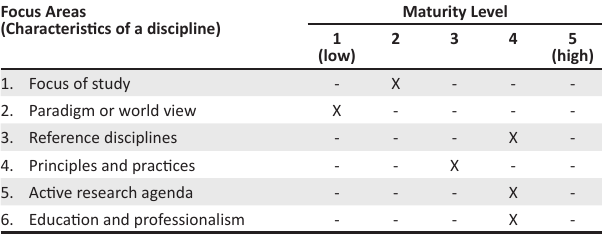
TABLE 6: DRM disciplinary status: Applying a Focus Area Maturity Model. Focus Areas (Characteristics of a